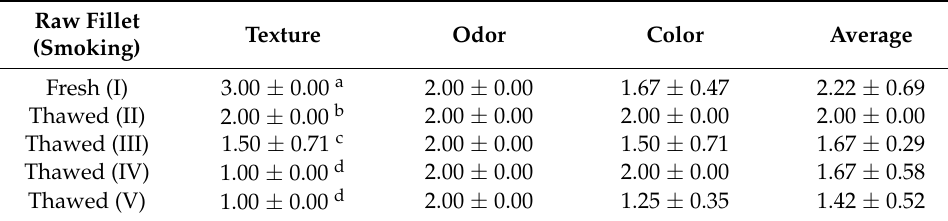
Table 4. Sensory analysis measured in fresh and thawed Dicentrachus labrax fillets. Raw